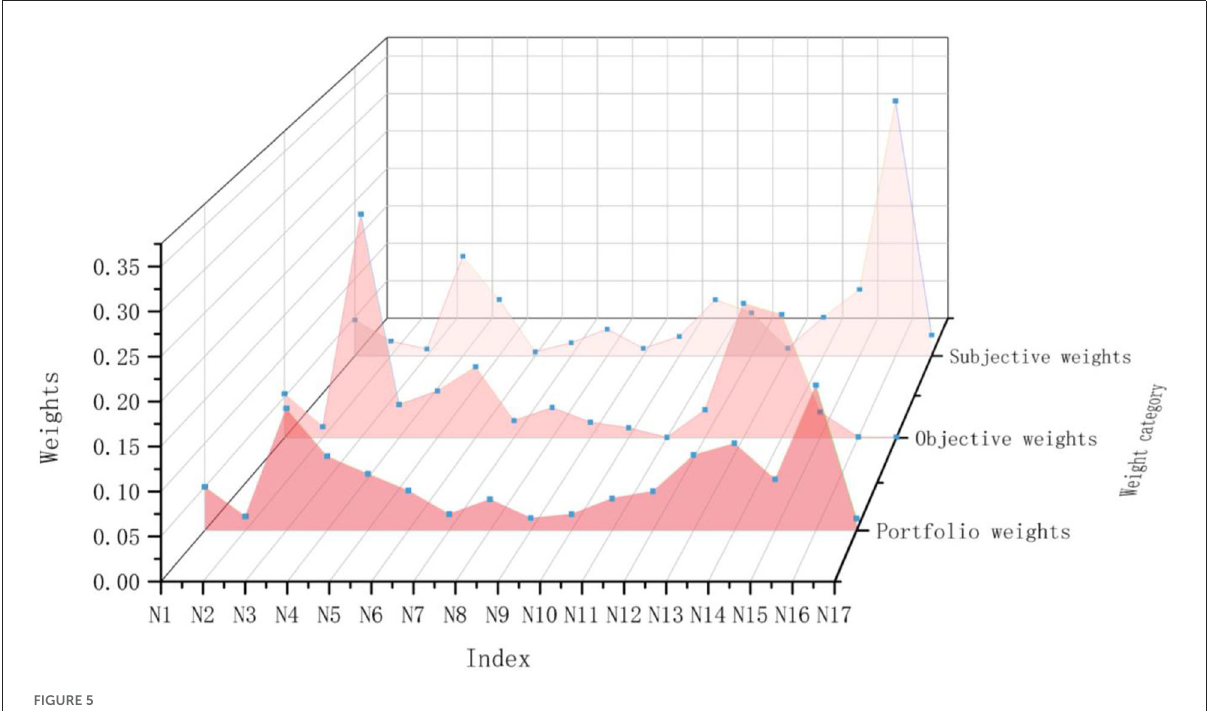
FIGURE5 Comparison of the three weight values.